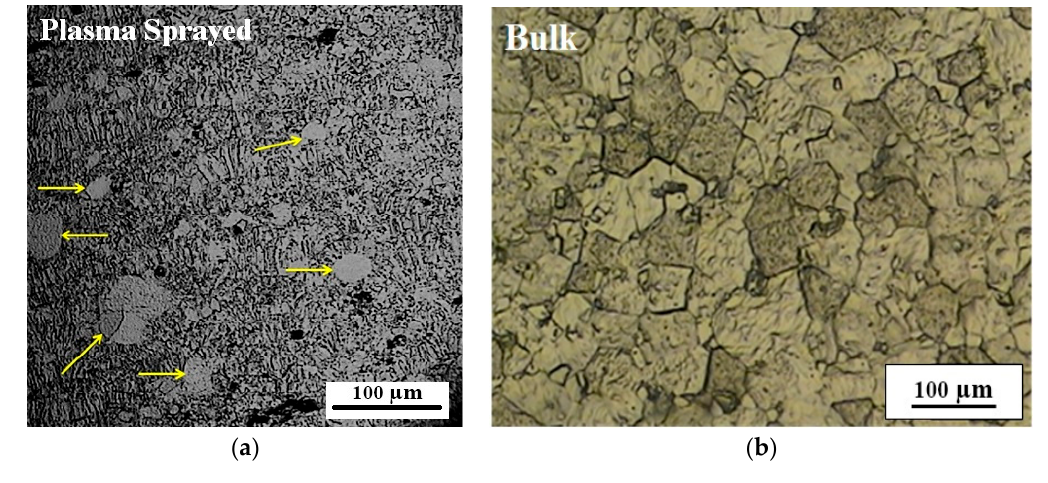
Figure 1. Structure the samples of Set 1 ( a ) and Set 2 ( b ).